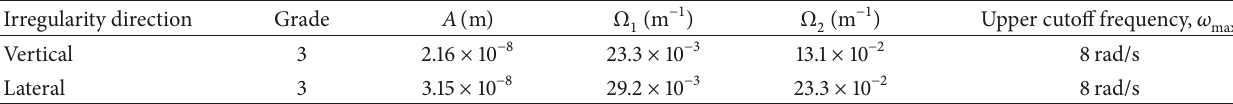
Table 4: Parameters for the PSD function by FRA.